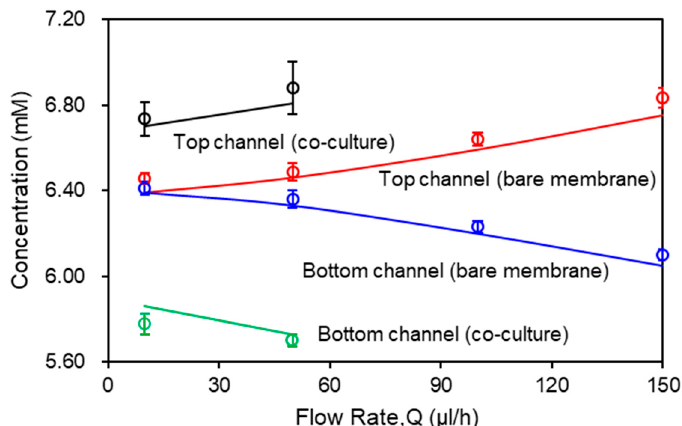
Figure 4. Glucose concentration as a function of flow rate. Computational results are represented by solid curves. Experimental data are represented by open circles in the corresponding color.